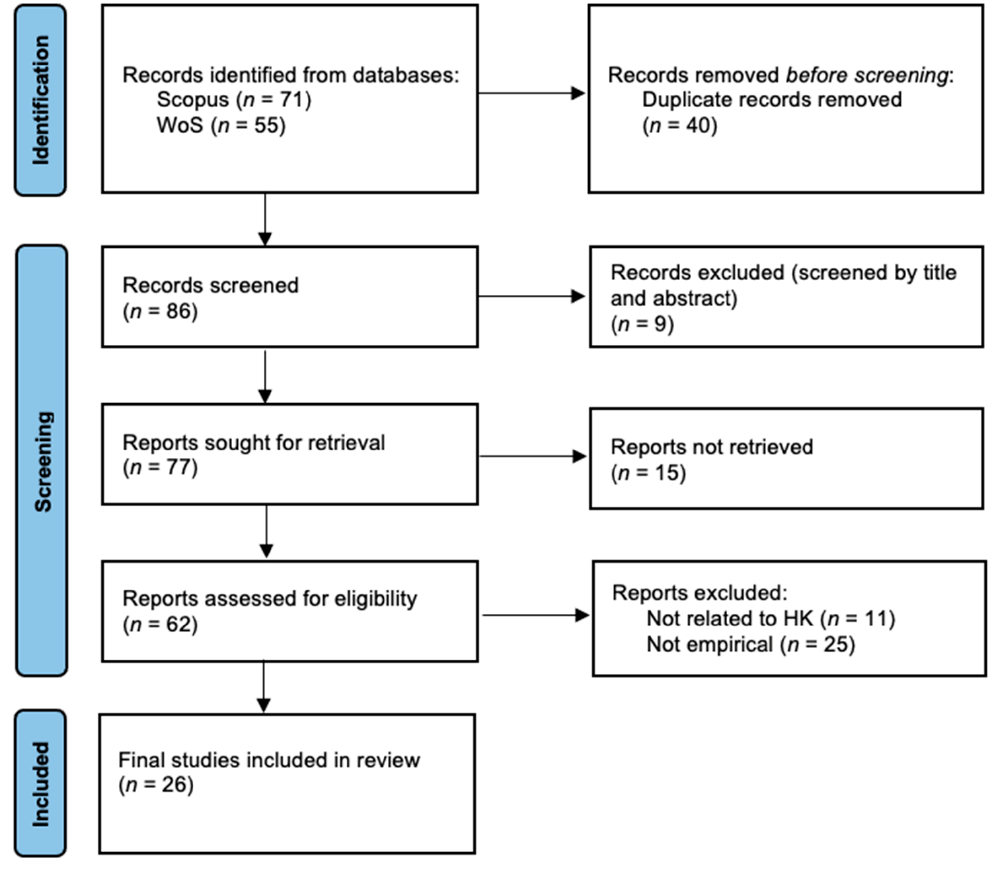
Figure 1. Flow diagram by Prisma 2020.